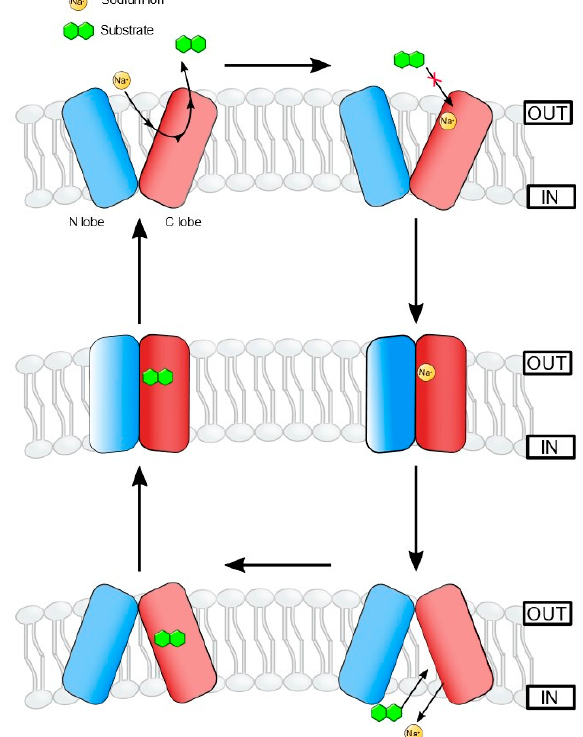
Figure 2. Based on the crystal structures of PfMATE (H + -coupled DinF protein from Pyrococcus furiosus [89,98], Kusakizako and colleagues have proposed an “alternating access mechanism” for the DinF-subfamily of MATE transporters [83]. Binding with Na + (or H + ) ions occurs at the Asp residue in the TM1 (N-lobe), which results in the bent conformation of TM1. In this state, TM1 assumes an outward open state. No substrate-binding takes place due to changes in the conformation at this stage. The following proposed form is a cation-bound occluded state, followed by an inward-open bent form, assuming a straight conformation to allow substrate binding. This step is followed by a substrate-bound occluded state, which finally enters into outward-open conformation.